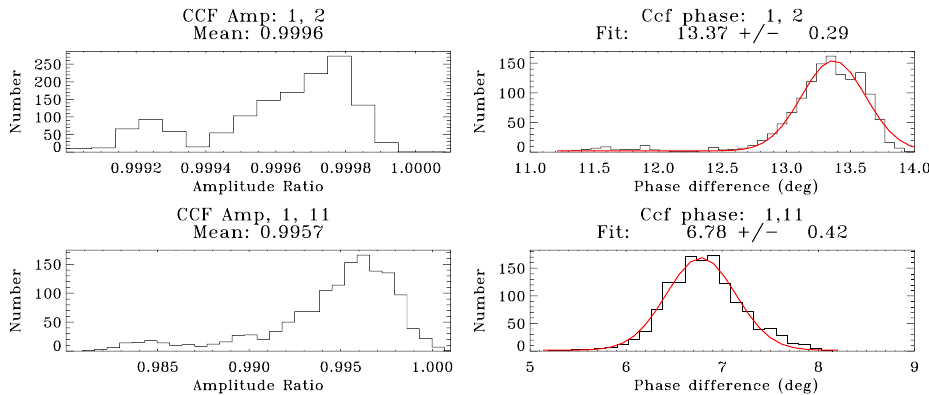
Fig. 1. Histogram of cross-correlation magnitude (left) and phase (right) estimated using receiving channels 1 and 2 (top) and 1 and 11 (bottom).